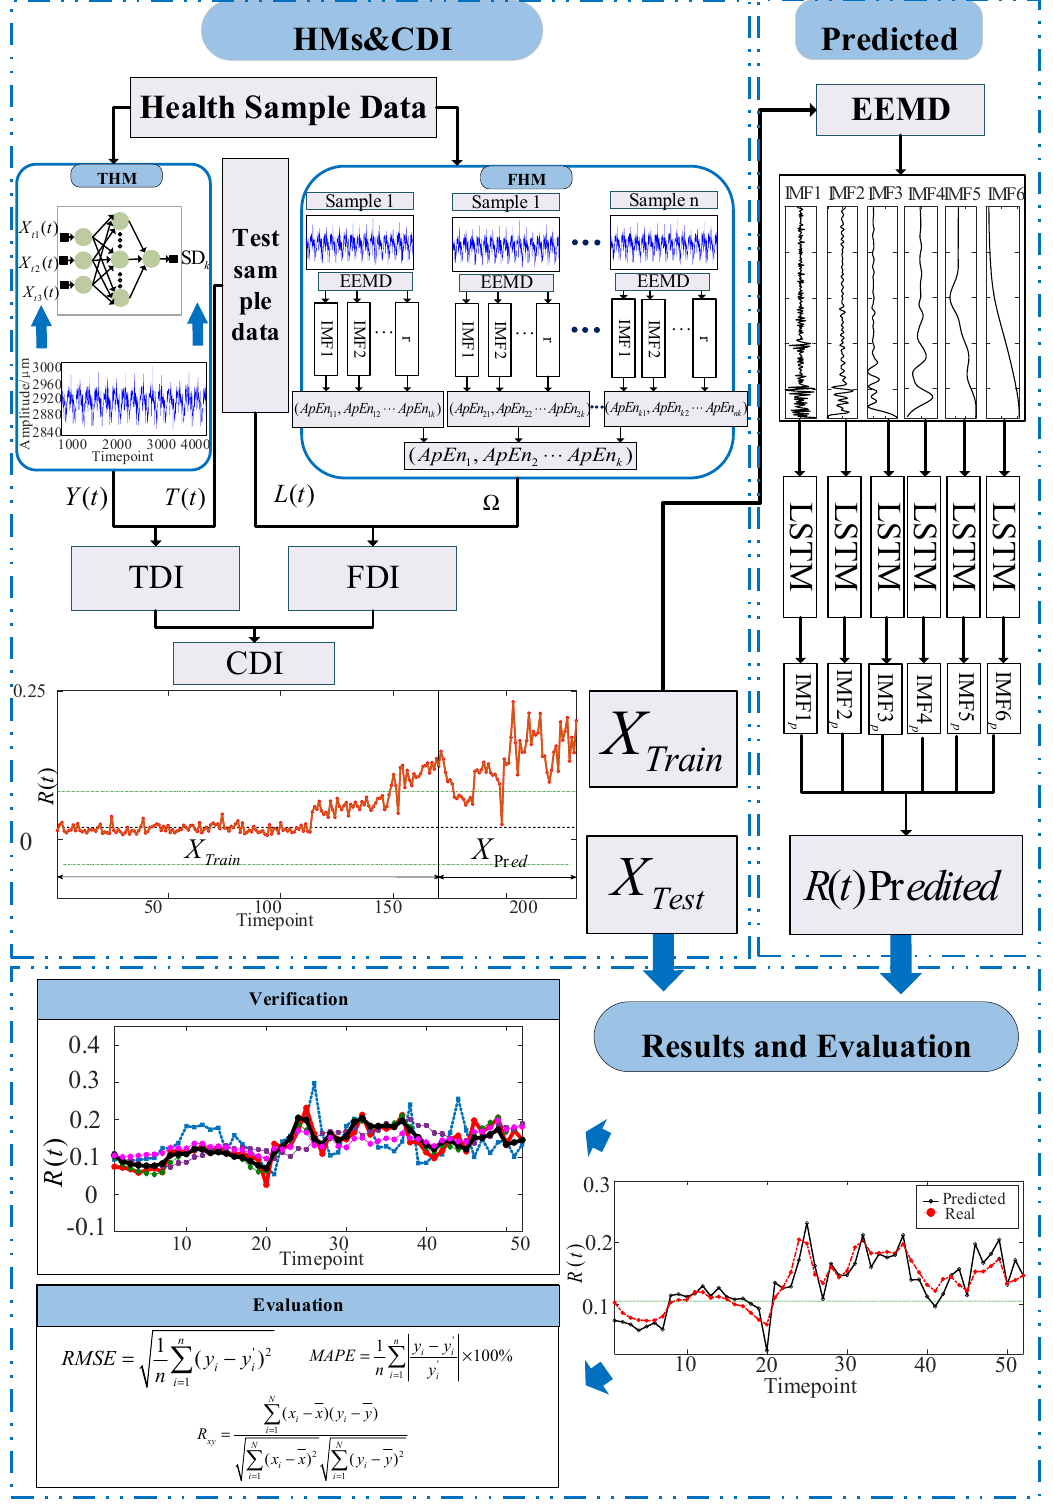
Figure 5. Trend prediction of hydropower unit health status based on CDI.